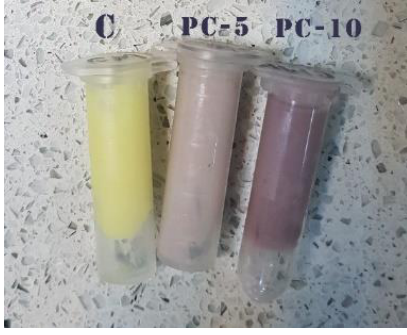
Figure 5. Pastry cream samples enriched with different levels of MBC powder (Control—0% MBC; PC-5—5% MBC; PC-10—10% MBC).